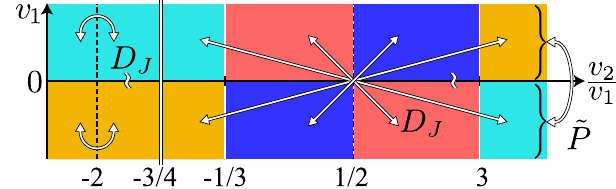
FIG. 14. Relations between the systems with parameters v 1 and v 2 =v 1 mapped using Eqs. (C4) and (C6). The color code indicates − 2 (turquoise), 4 (red), − 4 (blue), the winding number w 3 D ¼ and 2 (yellow), the same as in Fig.